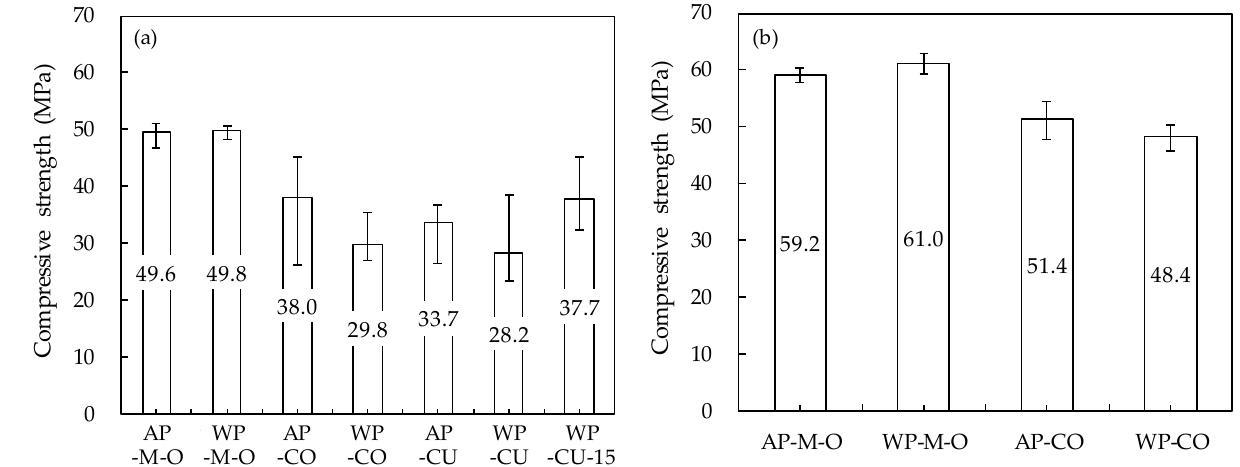
Figure 15. Compressive strength: ( a ) 7 days of age; ( b ) 28 days of age.